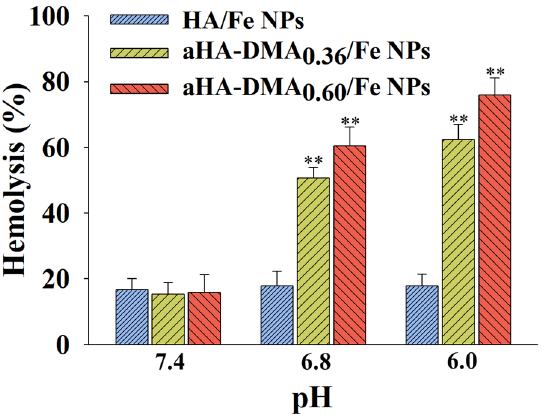
Figure 5. Hemolysis activity of the NPs (100 µ g/mL, without DOX) at pH 7.4, 6.8, or 6.0 ( n = 3, as multiple experiments, ** p < 0.01 compared to HA/Fe